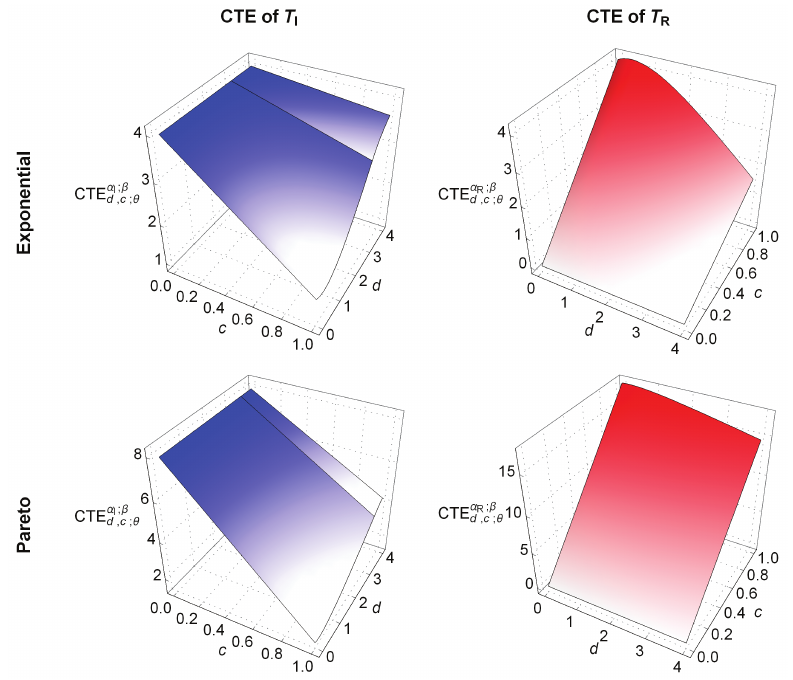
( T ) (on the left side) and CTE α R ; β I d , c ; θ